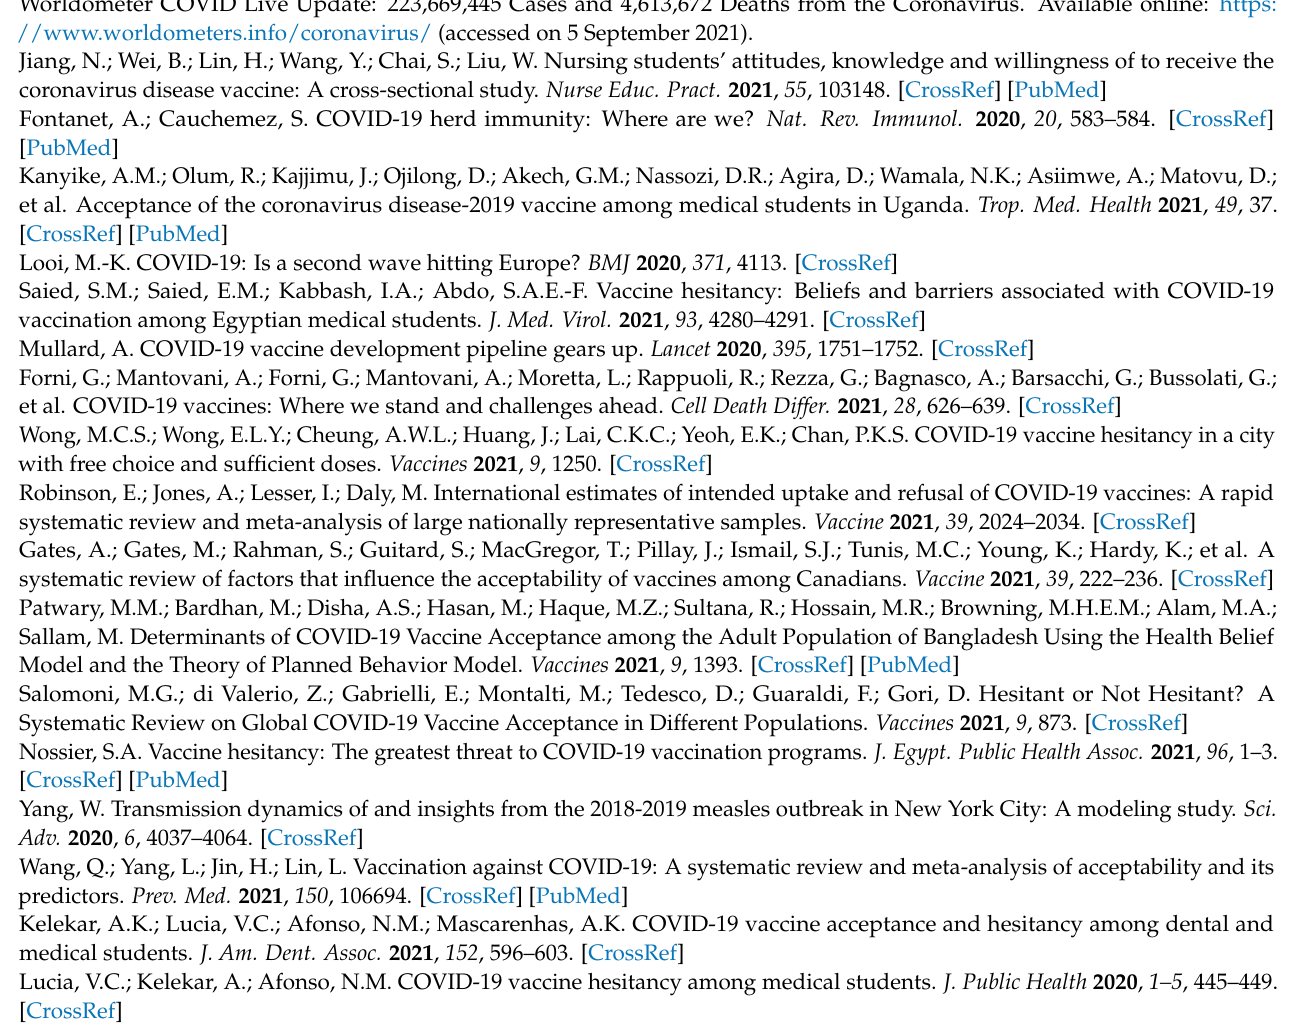
Table S1: Quality assessment of included